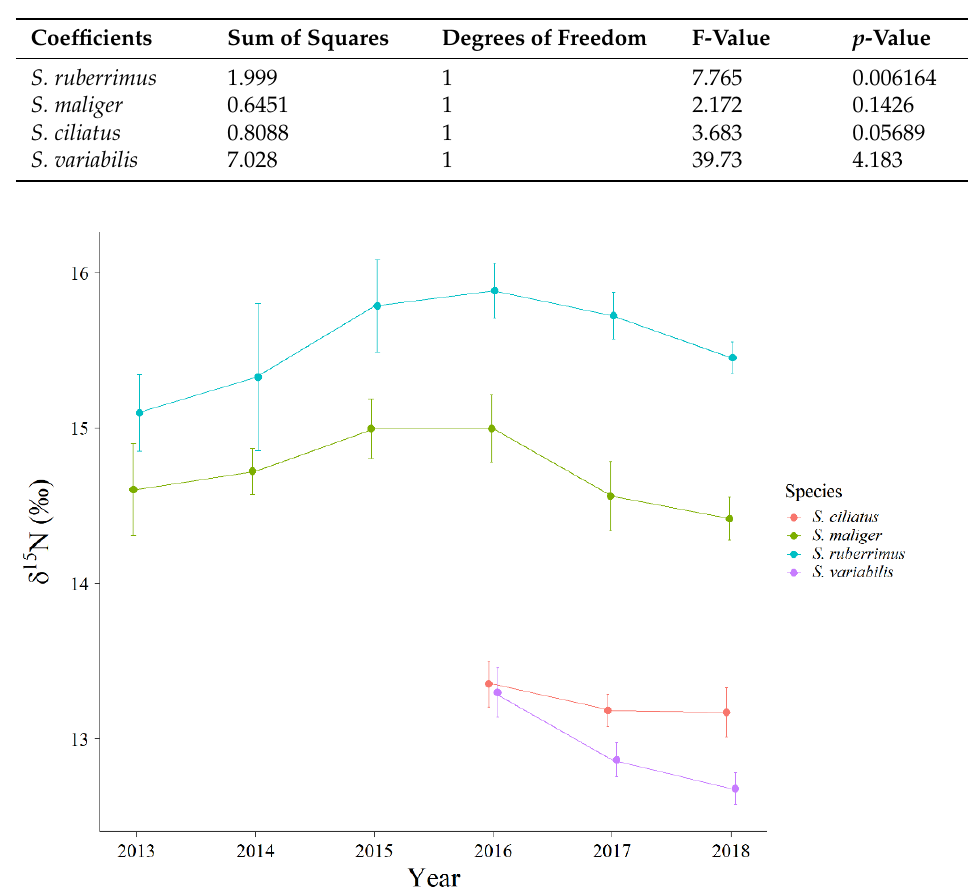
Table 5. Results from ANOVA test for δ 15 N across time for four rockfish species.